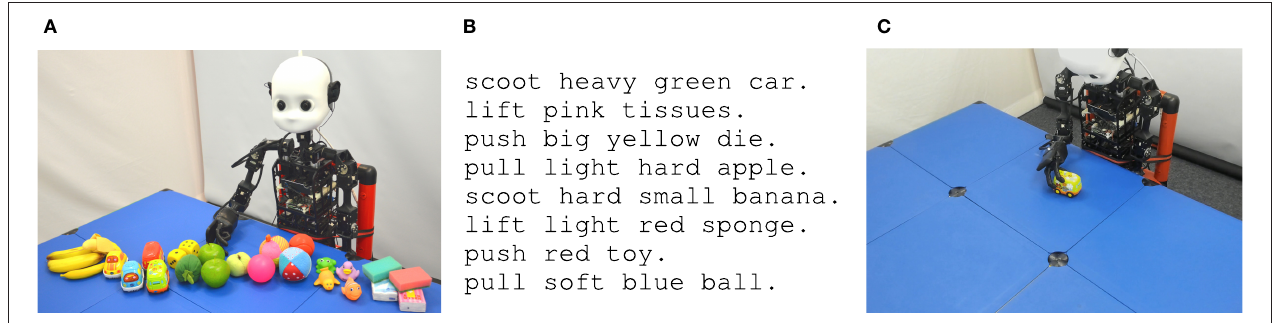
FIGURE 2 | Developmental robot scenario of the EMIL data collection (Heinrich et al., 2018b): NICO is interacting with objects and perceives the interaction on auditory, sensorimotor, and visual modalities. A teacher provides a description for the interaction. (A) Scenario, (B) Example descriptions, (C) Teacher